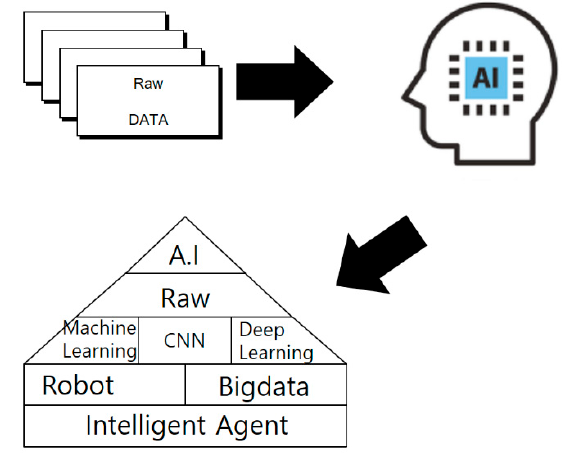
Figure 1. Artificial intelligence architecture for raw data.